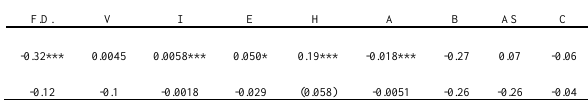
Table 4. Determinants of the spending on fresh vegetables Notes: Weighted least square regression results, N = 264,582. First row: Marginal fresh vegetable spending. Second row: robust standard errors clustered at household level.